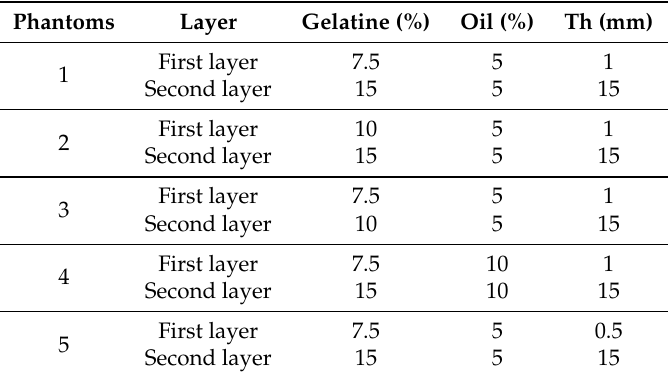
Table 2. Percentages of gelatine and oil wt/wt, as well as the thickness (Th) of the two layers for each of the five phantoms.